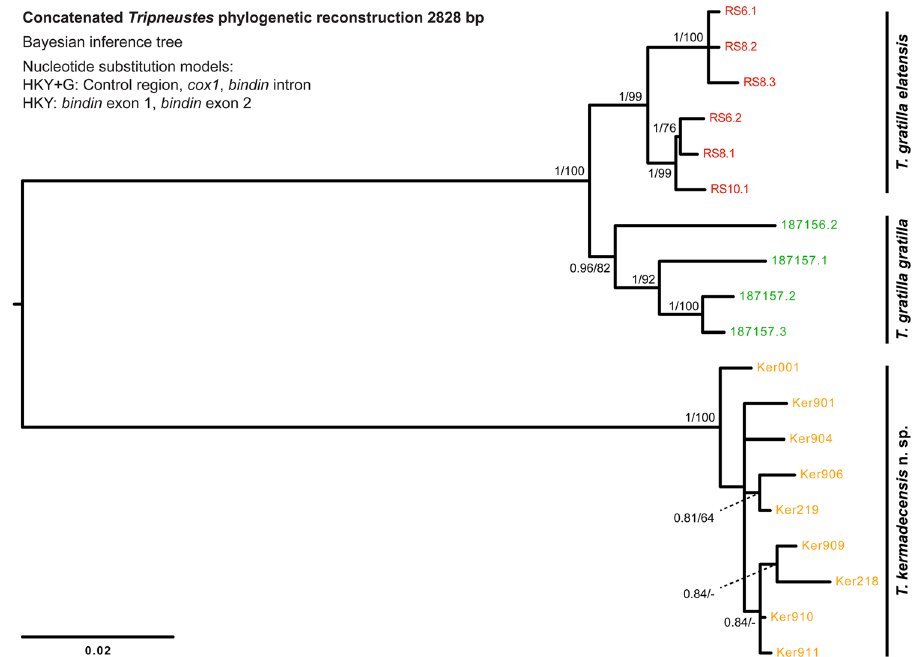
Figure 9. Phylogenetic tree reconstruction of concatenated Tripneustes sequences. The mid-point rooted BI tree reconstruction is based on 19 unique haplotypes, 2828 bp long, representing T . kermadecensis n. sp., T . g . elatensis and T . g . gratilla . Sequences were concatenated from alignable segments of the mitochondrial markers ( COI and CR) as well as the nuclear marker bindin (including exons 1, 2 and the intron). Color code as in Fig. 5. Supporting values ( > 0.9 posterior probabilities and > 60% ML bootstrap values) are shown near the nodes. Details on the sequences used for this tree are given in the Supplementary Table S1.